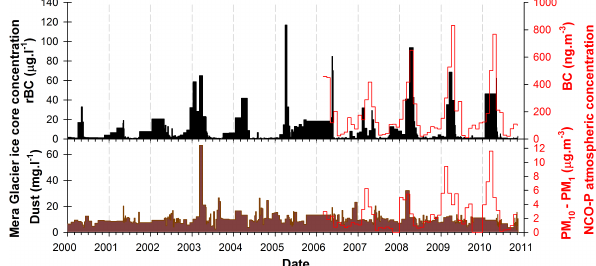
Figure 4. Atmospheric BC and dust (red lines, scales on the right vertical axis) measured monthly at the NCO-P site, and changes in surface snow concentrations of rBC (black bar, scales on the left vertical axis) and dust (drown bar) reconstructed from dated firn core